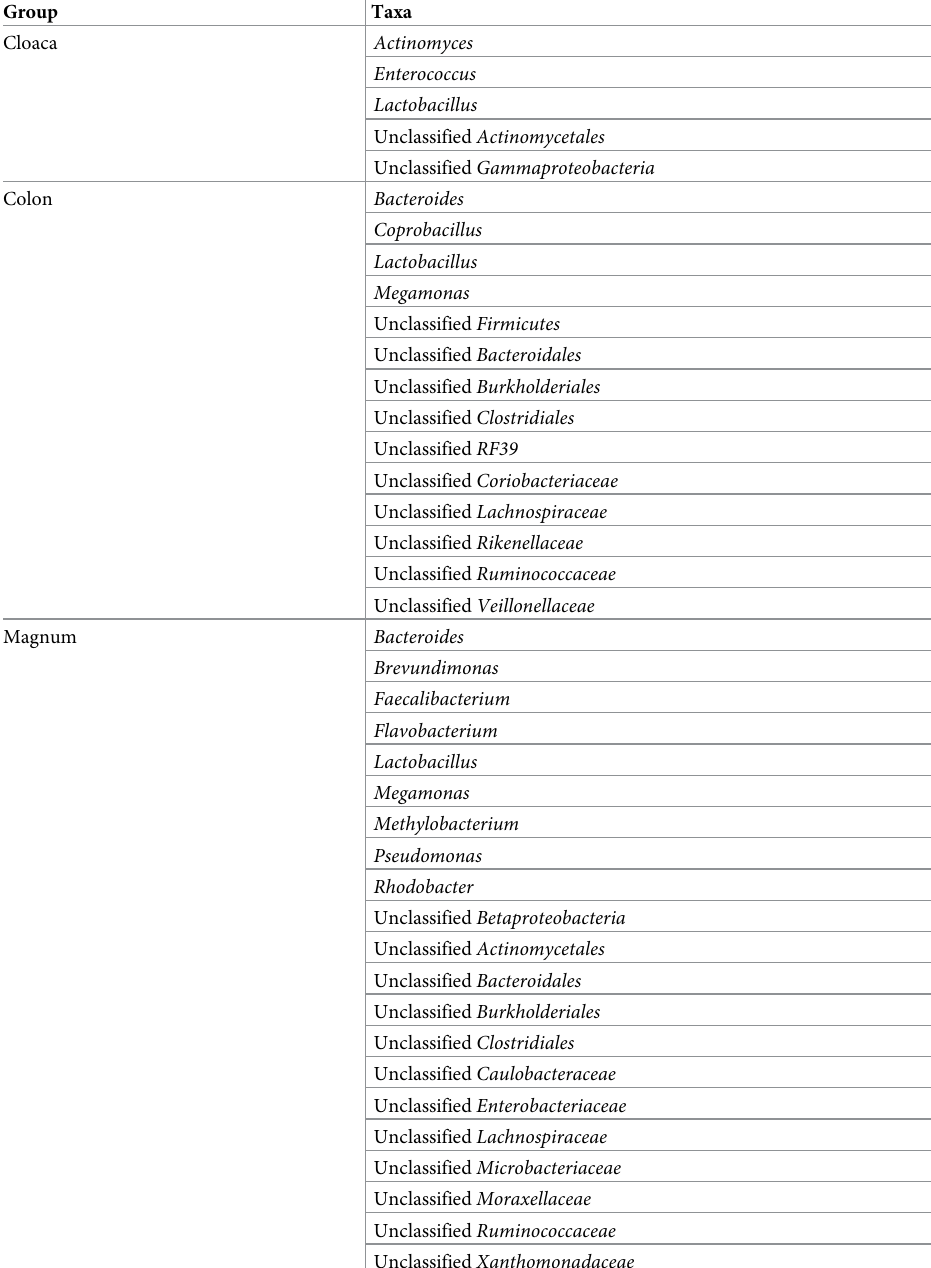
Table 5. Core taxa � of each sampling